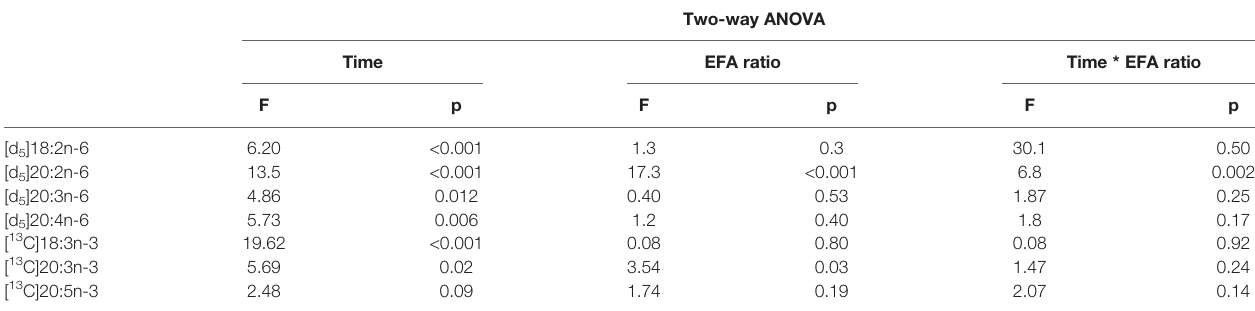
TABLE 4 | Statistical analysis of the effects of EFA ratio and duration of incubation on the mitogen-induced change in the amount of labelled PUFA in T cells.